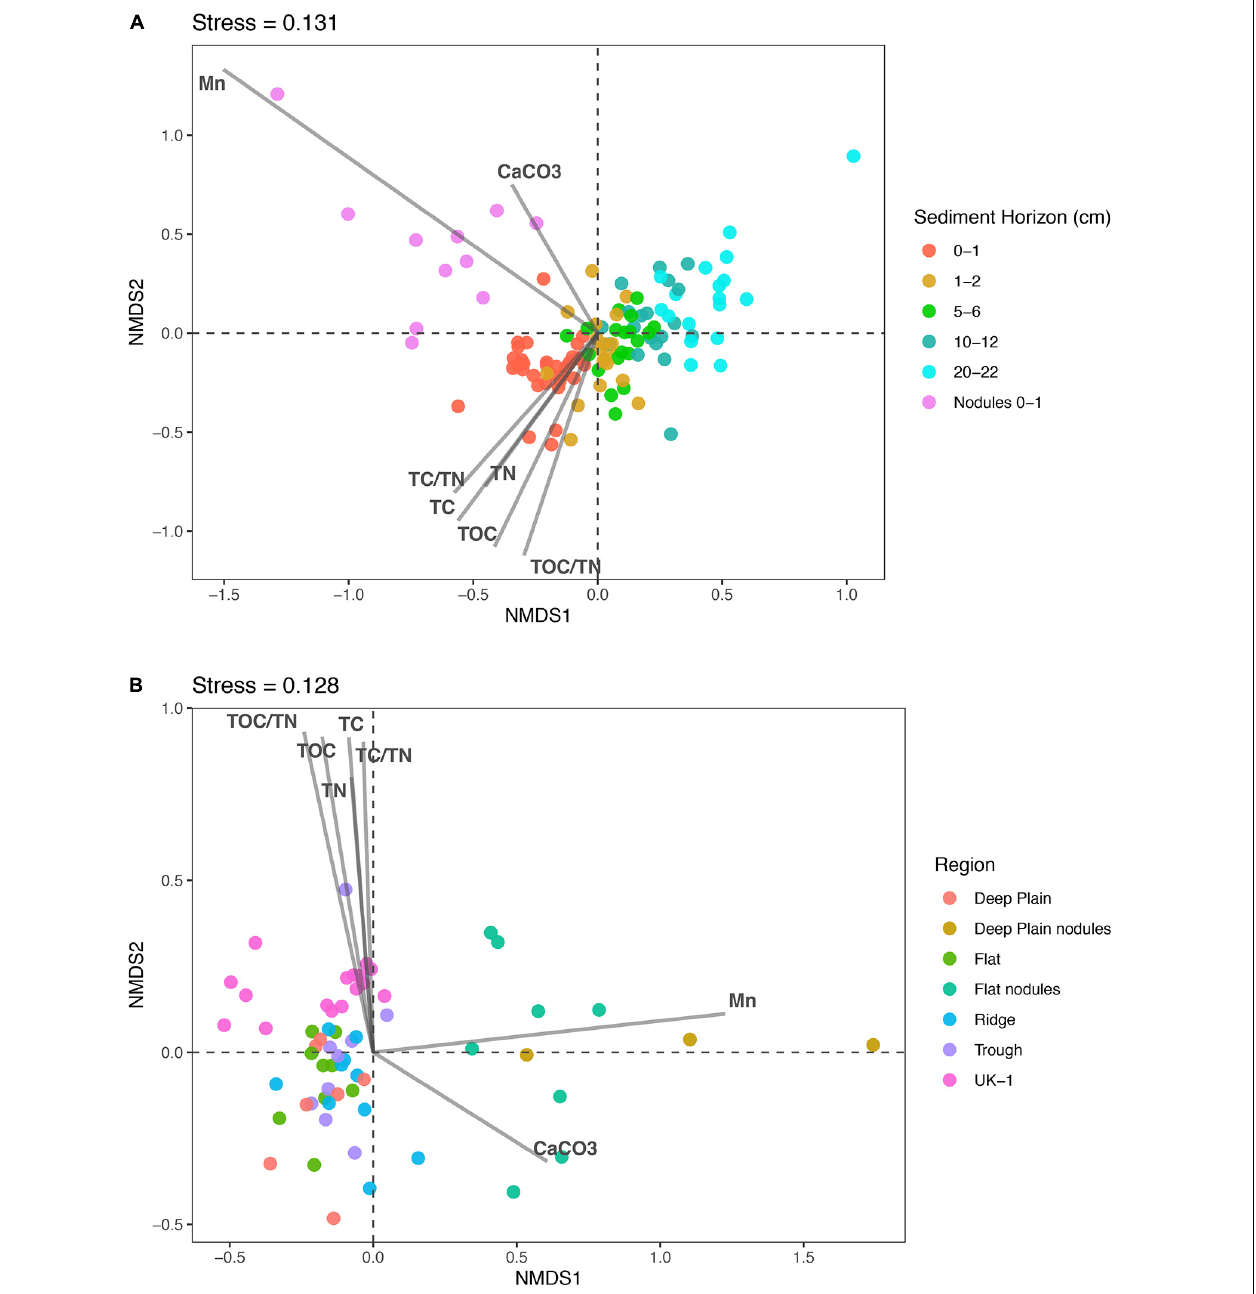
FIGURE 3 | Non-metric multidimensional scaling (nMDS) plots of microbial community dissimilarity based on Bray-Curtis distances. The points represent individual samples and their proximity to one another indicates their similarity. The closer the points are to each other, the more similar the samples are to each other based on community structure and composition. (A) Nodule-associated and sediment communities through the sediment profile (0–22 cm) from APEI-6 and UK-1 in the CCZ. Nodules are from the surface sediments (0–1 cm) of the Deep Plain and Flat regions of APEI-6. (B) Sediment communities in the top 2 cm of sediment across the four regions in APEI-6 and sediment at UK-1. Nodules are from the surface sediments (0–1 cm) of the Deep Plain and Flat regions of APEI-6. The relationship of environmental variables to the samples are shown with arrows, where the greater the arrow length, the stronger the correlation. Environmental variables are from Jones et al., 2021, in prep.) and Menendez et al.